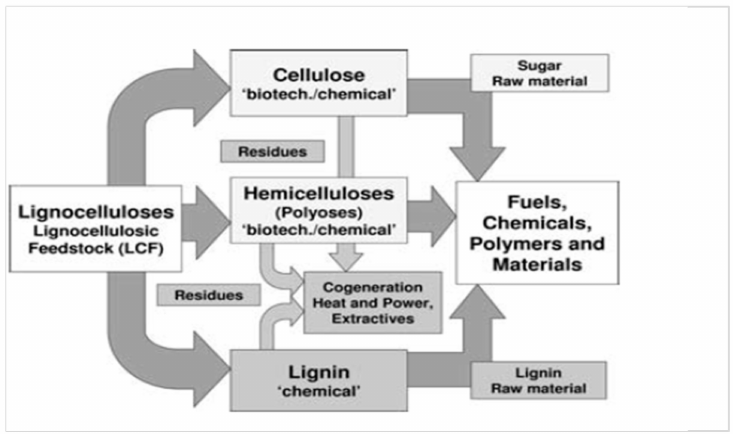
Figure 1. Lignocellulosic feedstock biorefinery [4]. Copyright 2018 WILEY-VCH Verlag GmbH & Co. KGaA, Weinheim.